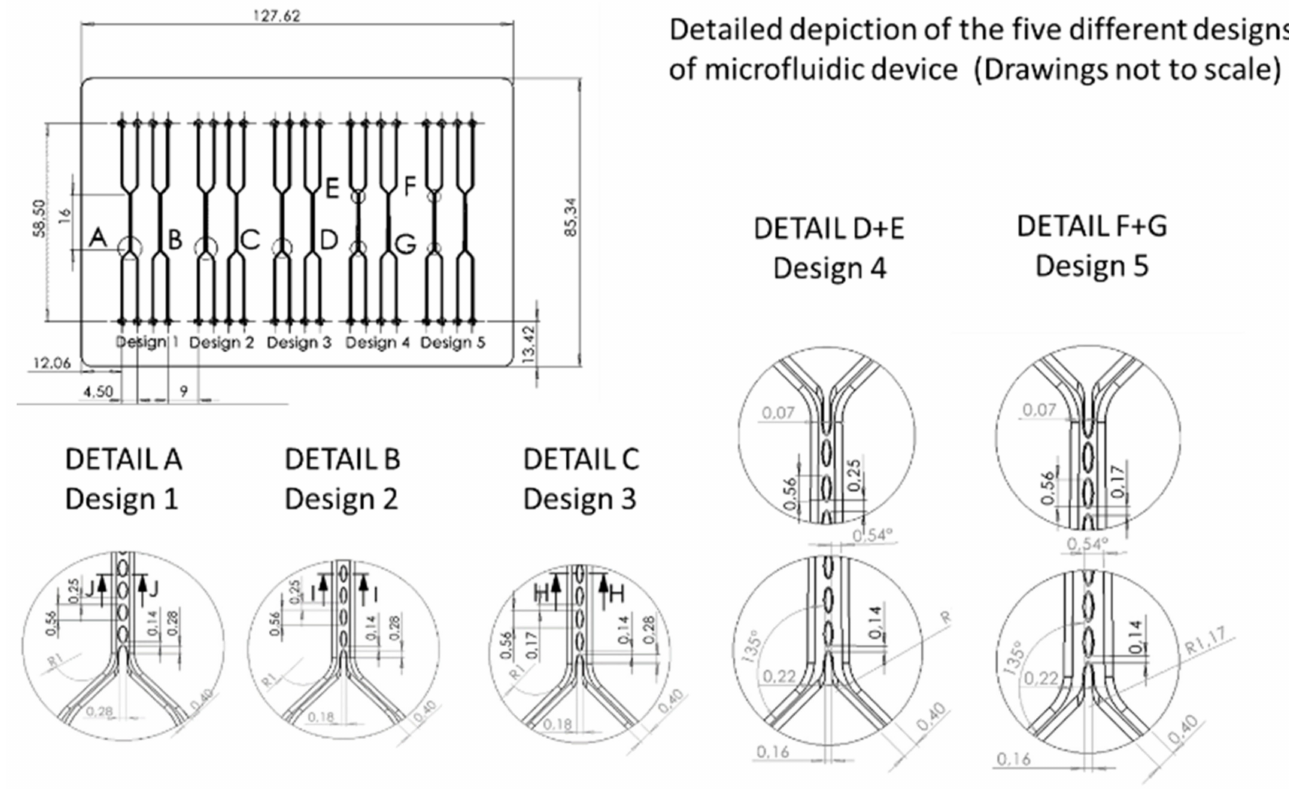
Figure A1. Layout of channels and culture areas on the MFC, 5 groups of culture areas with various pillar sizes, designs and spacings were designed (Table A1). The channel depth is 170 µ m in all